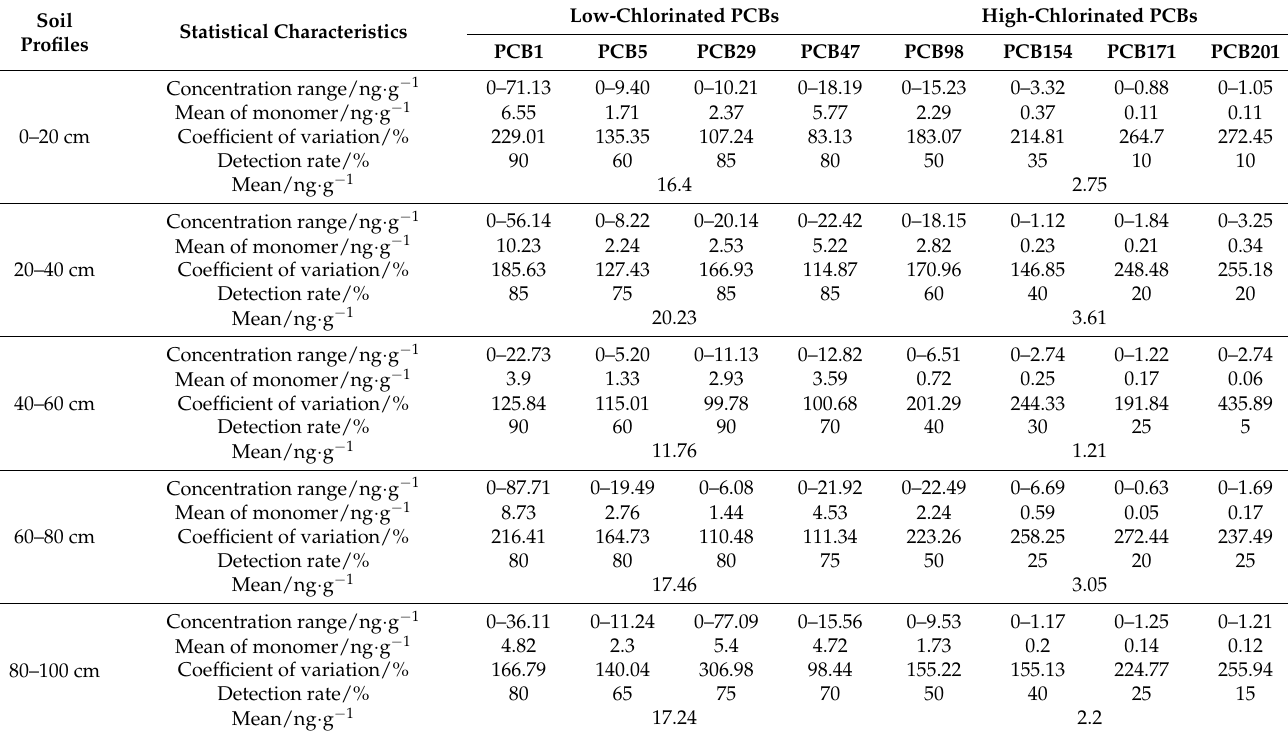
Table 2. Statistical characteristics of PCBs in